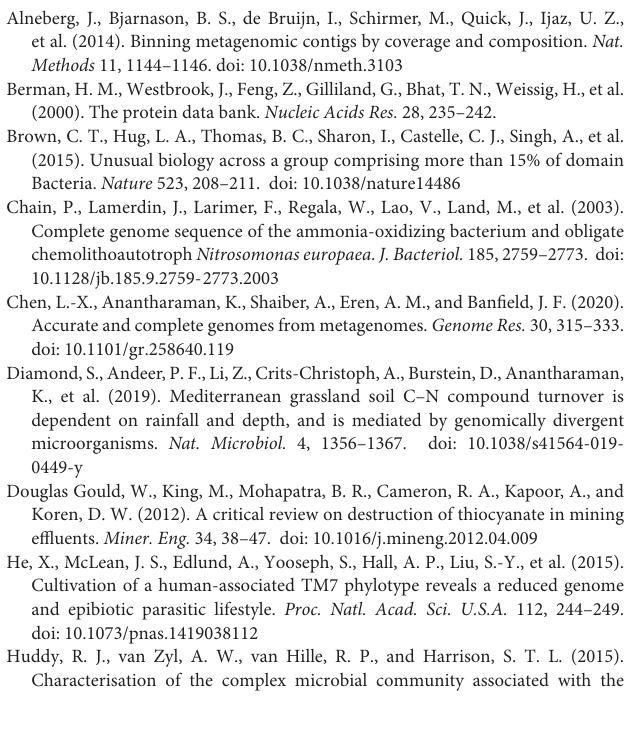
Supplementary Figure 5 | Version of Figure 6B showing organism names. Supplementary Table 1 | Solution chemistry from the five reactors. Supplementary Table 2 | Percentage of reads from each sample that map to the 232 genomes. Supplementary Table 3 | Abundances of organisms represented by 232 genomes across the samples from the five reactors. Supplementary Table 4 | The relative abundances of bacteria that were abundant in R1 (molasses) and R5 (no molasses) that were amended with thiocyanate and ramped to 2000 mg/L in the five reactors and over